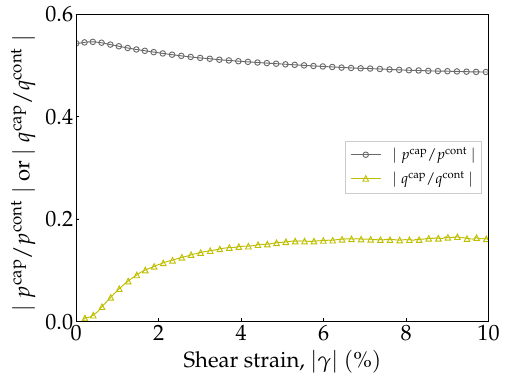
Figure 5. The evolution of capillary stress components during DEM simple shear test ( κ t